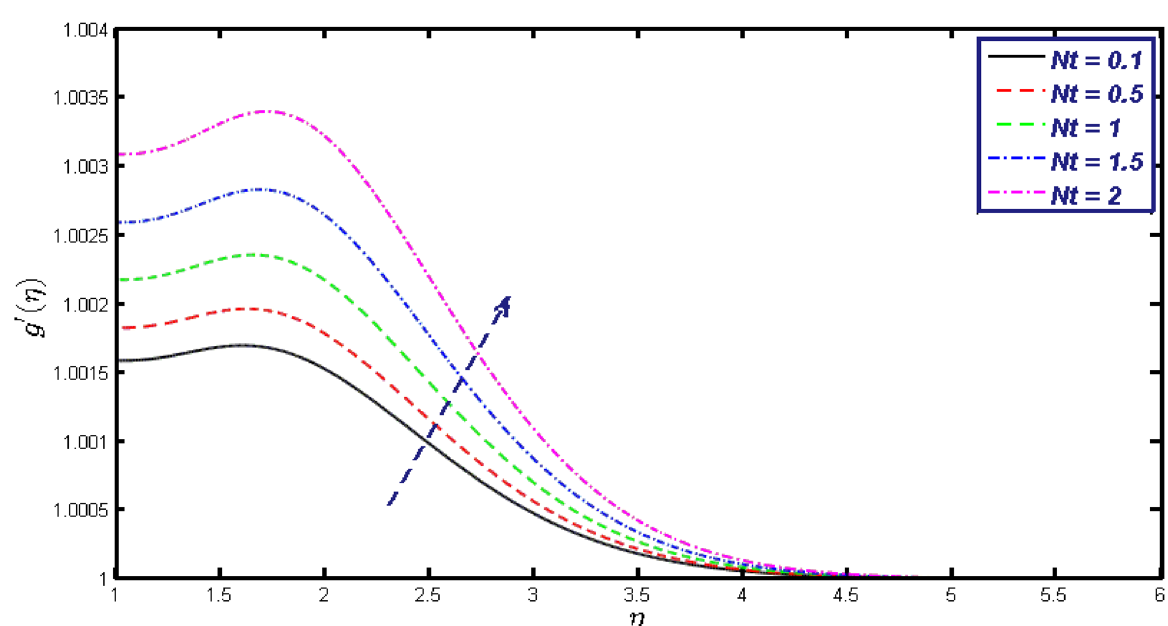
Figure 18. g ′ (η) field for distinct values of Nt